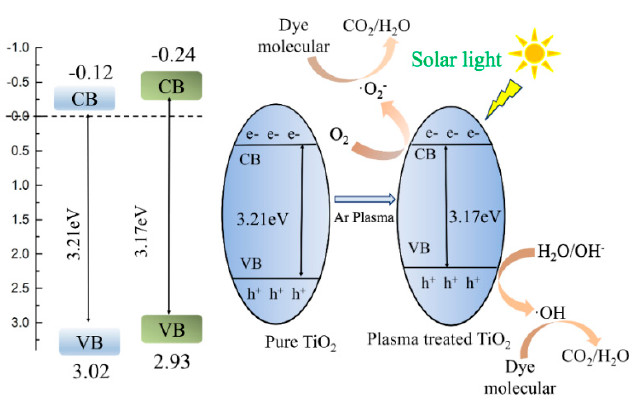
Figure 4. Schematic drawing illustrating the mechanism of charge separation and photocatalytic activity of the TiO 2 photocatalyst under solar light irradiation.